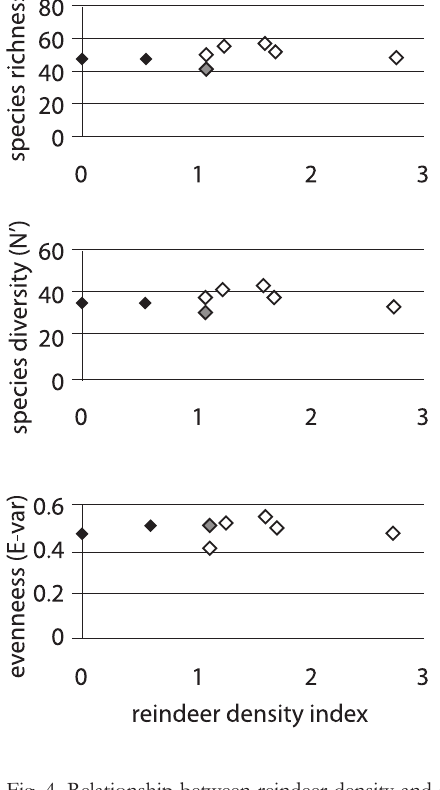
Fig. 4. Relationship between reindeer density and species richness, species diversity and species evenness. The two sites inside Malla Reserve are marked with black squares and Saana is marked with gray squares.